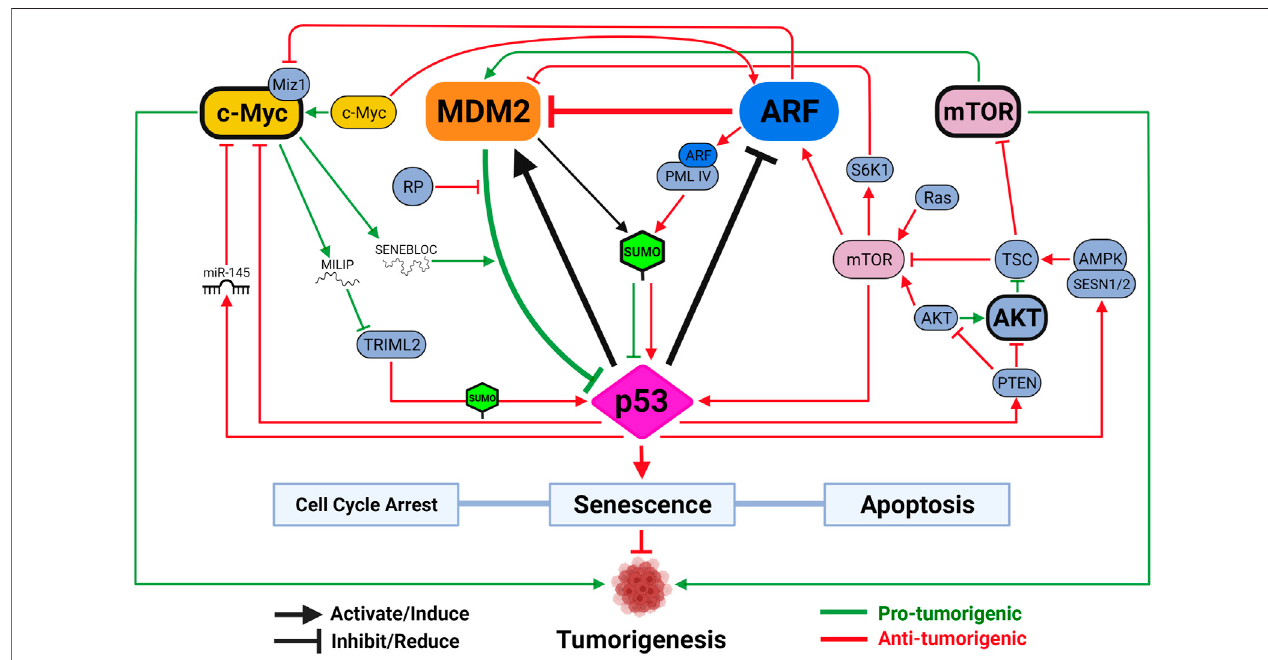
FIGURE 2 | The functional triangle between p53, MDM2 and ARF. The MDM2-p53 duplex is considered the central hub controlling p53-mediated tumor- suppressive activities. Mechanisms disrupting MDM2-p53 interaction lead to p53 activation, which induces MDM2 expression through a negative feedback loop. ARF promotes p53 activation by inhibiting MDM2. Activated p53 reduces ARF expression through HDAC and PcG transcriptional repressors, and loss of p53 often leads to ARF induction. mTOR and c-Myc are two versatile signaling factors that mediate tumor-regulating mechanisms by engaging with all three members ofthe triangle. Both mTOR and c-Myc (unbolded) induce p53 activation when initially encountering DNA damage stress but are both capable of, upon overexpression or sustained activation (bolded), promoting tumorigenesis by inhibiting p53 activity. Created with BioRender.com.